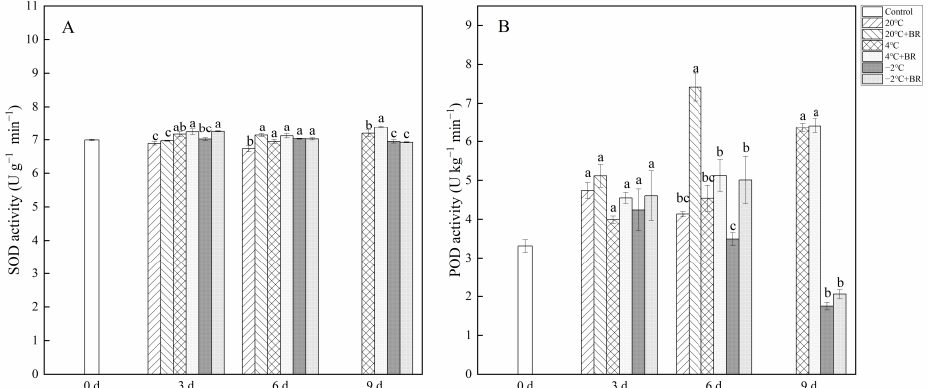
Int. J. Mol. Sci. 2022 , 23 , x FOR PEER REVIEW